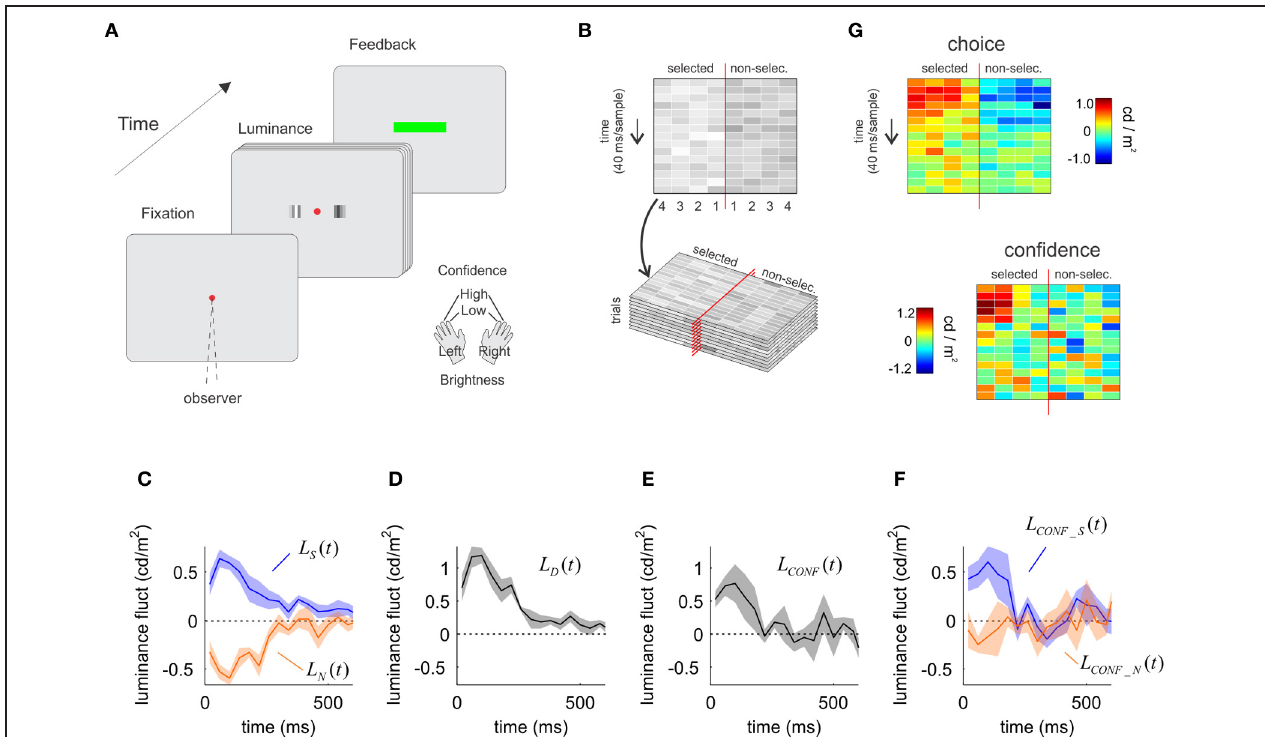
FIGURE 2 | The influence of sensory evidence onchoice and confidence derived from a luminance discrimination task. (A) A trial of the luminance task. Two patches of flickering bars (updated at 25Hz) were presented until participants made a response. Participants indicated which patch is brighter and the confidence in their decision with a single manual response. (B) Spatiotemporal profile of the luminance signal. The red vertical line represents the fixation point, and the four columns to each side indicate the luminance in time of the four bars in each patch, numbered from the fovea to the periphery. (C) Time course of the influence of luminance fluctuations on choice. Luminance fluctuations were obtained by subtracting from the luminance of each bar the mean of the distribution used to sample the luminance values,andaveraging acrossthefourbarsineachpatch.Onaverage,